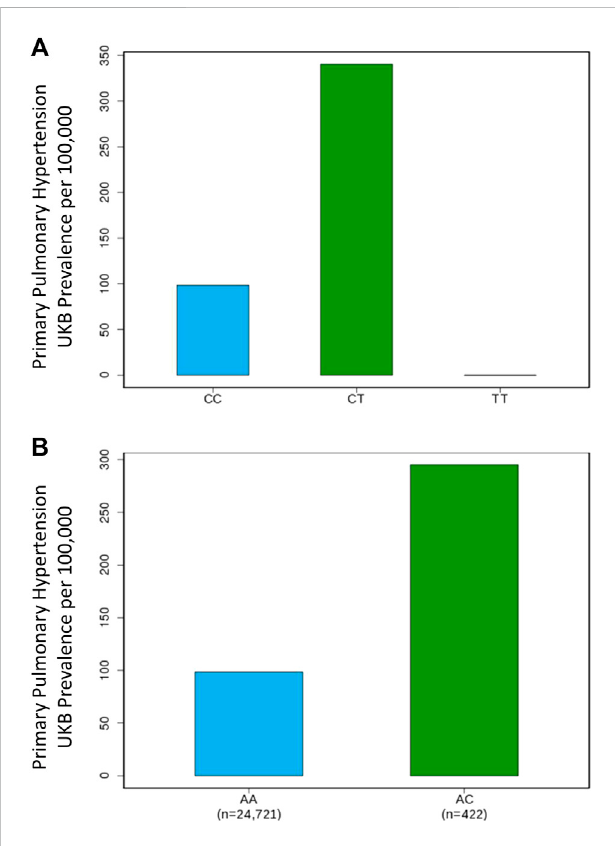
FIGURE 3 Genome-wide association study results for PIM1 and LINC01491 variants associated with pulmonary arterial hypertension. (A) Prevalence of PAH in the UK Biobank increases with PIM1 variant rs192449585 status. CC denotes wildtype, CT denotes heterozygous carrier, TT denotes homozygous carrier. (B) Prevalence of PAH in the UK Biobank increases with LINC01491 variant rs145733648 status. AA denotes wildtype, AC denotes heterozygous